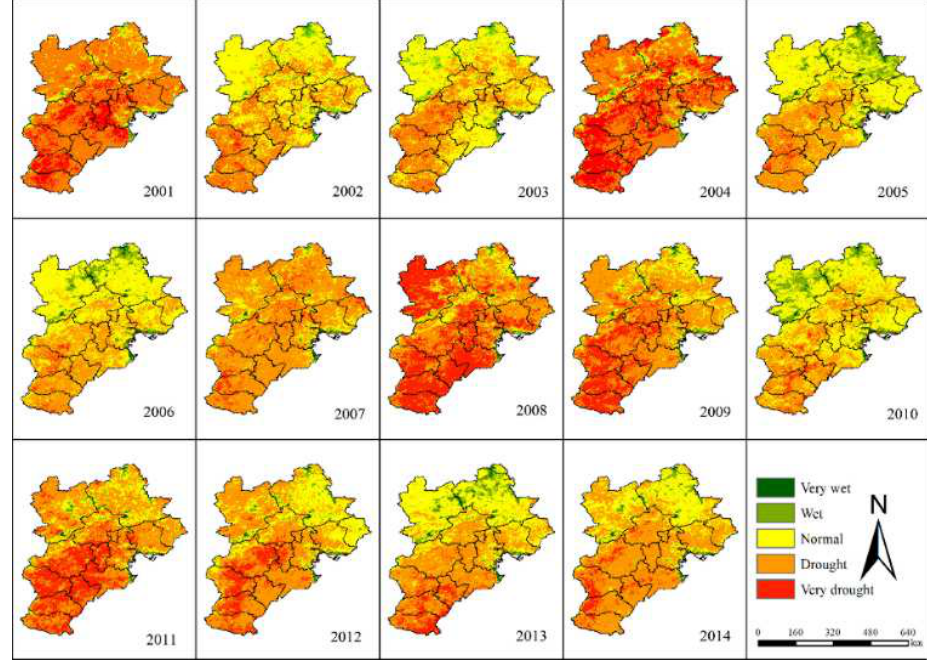
Figure 4. TVDI images from 2001 to